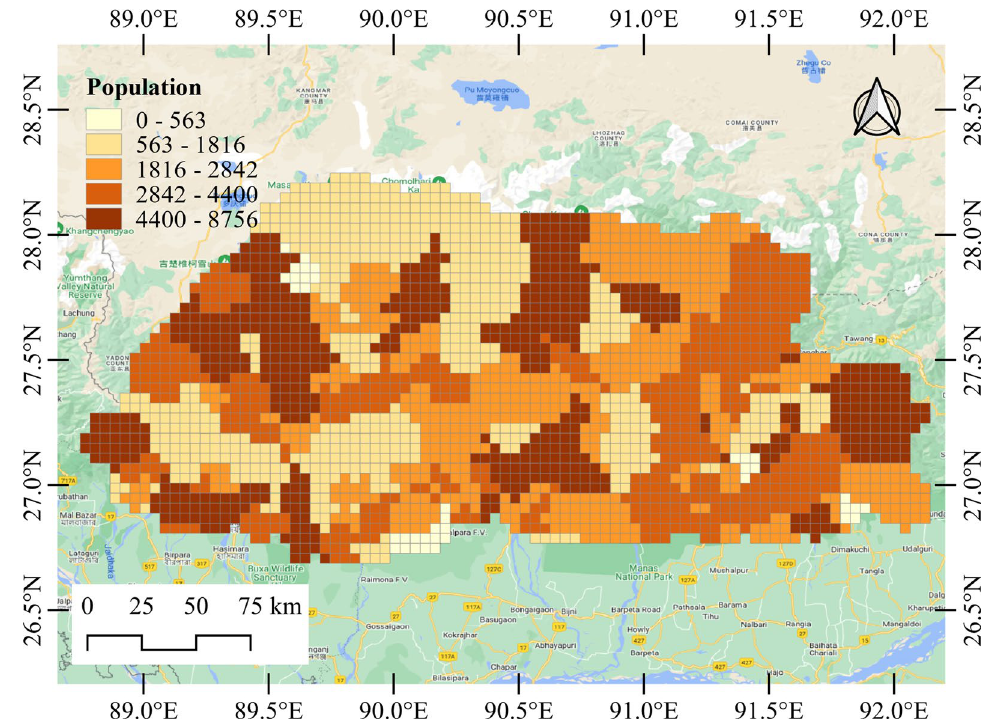
Fig. 9 Local-level population distribution of